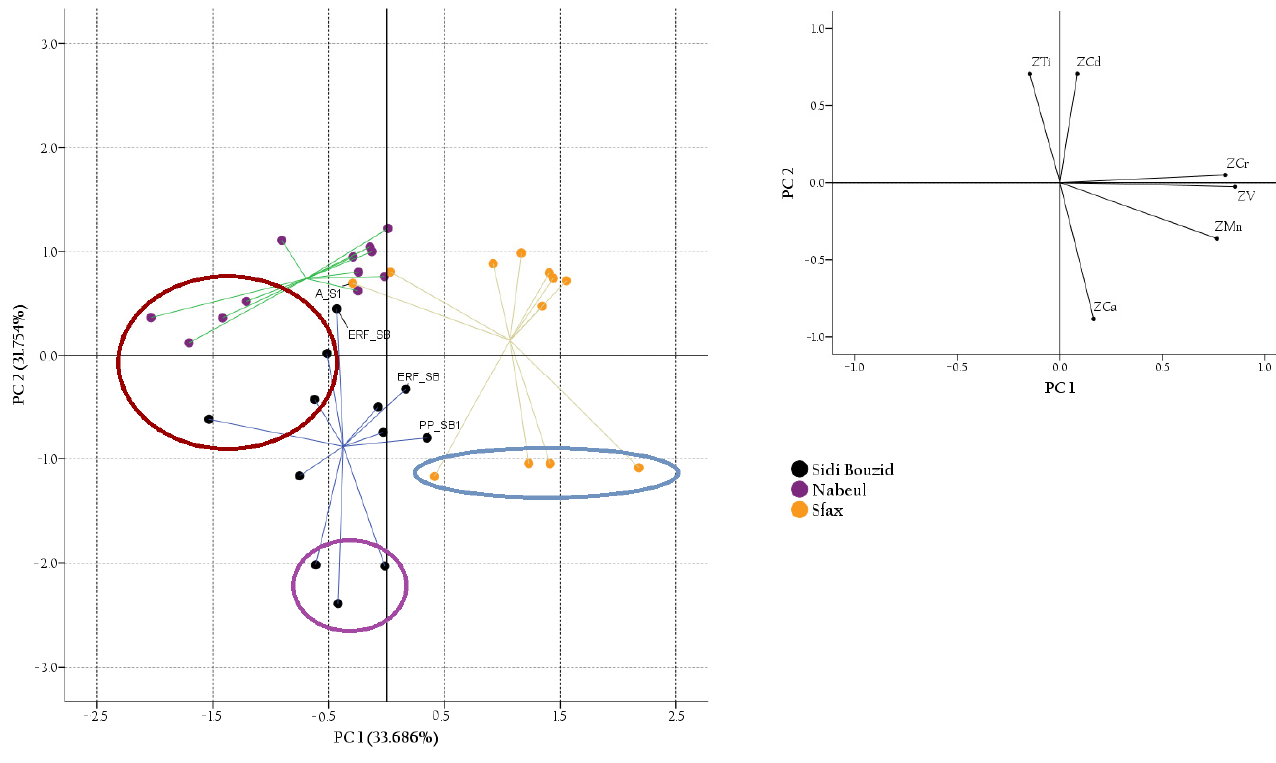
Figure 3. Two-dimensional score plots for the 36 honey samples categorized by geographical origin. Inserts: loadings plot for PC1 and PC2. Outcome obtained with 6 variables and with Varimax rotation.